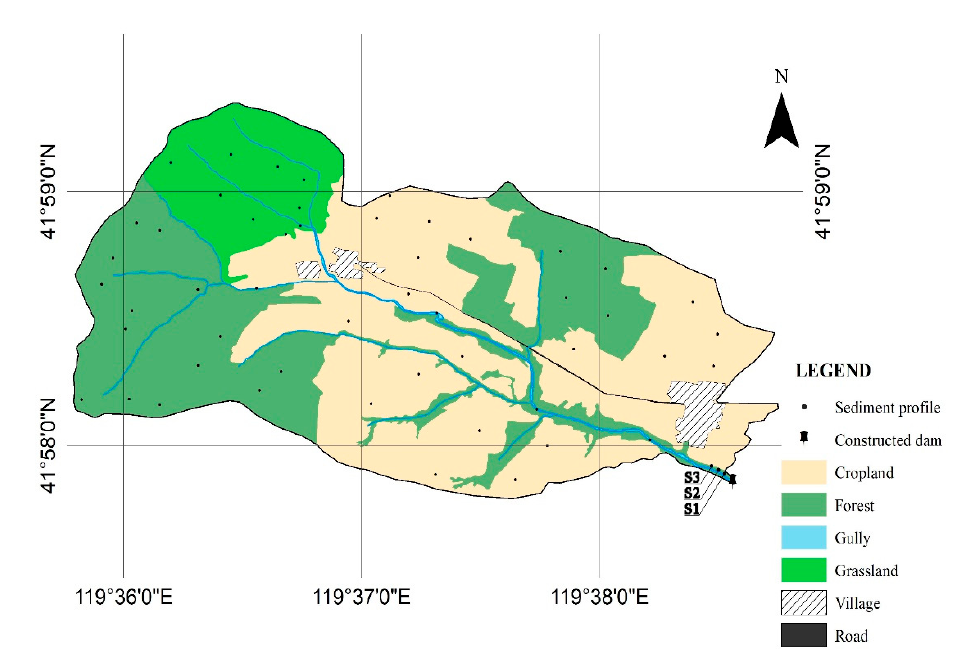
Figure 1. Site location, land uses, and sampling points (dots) of studied